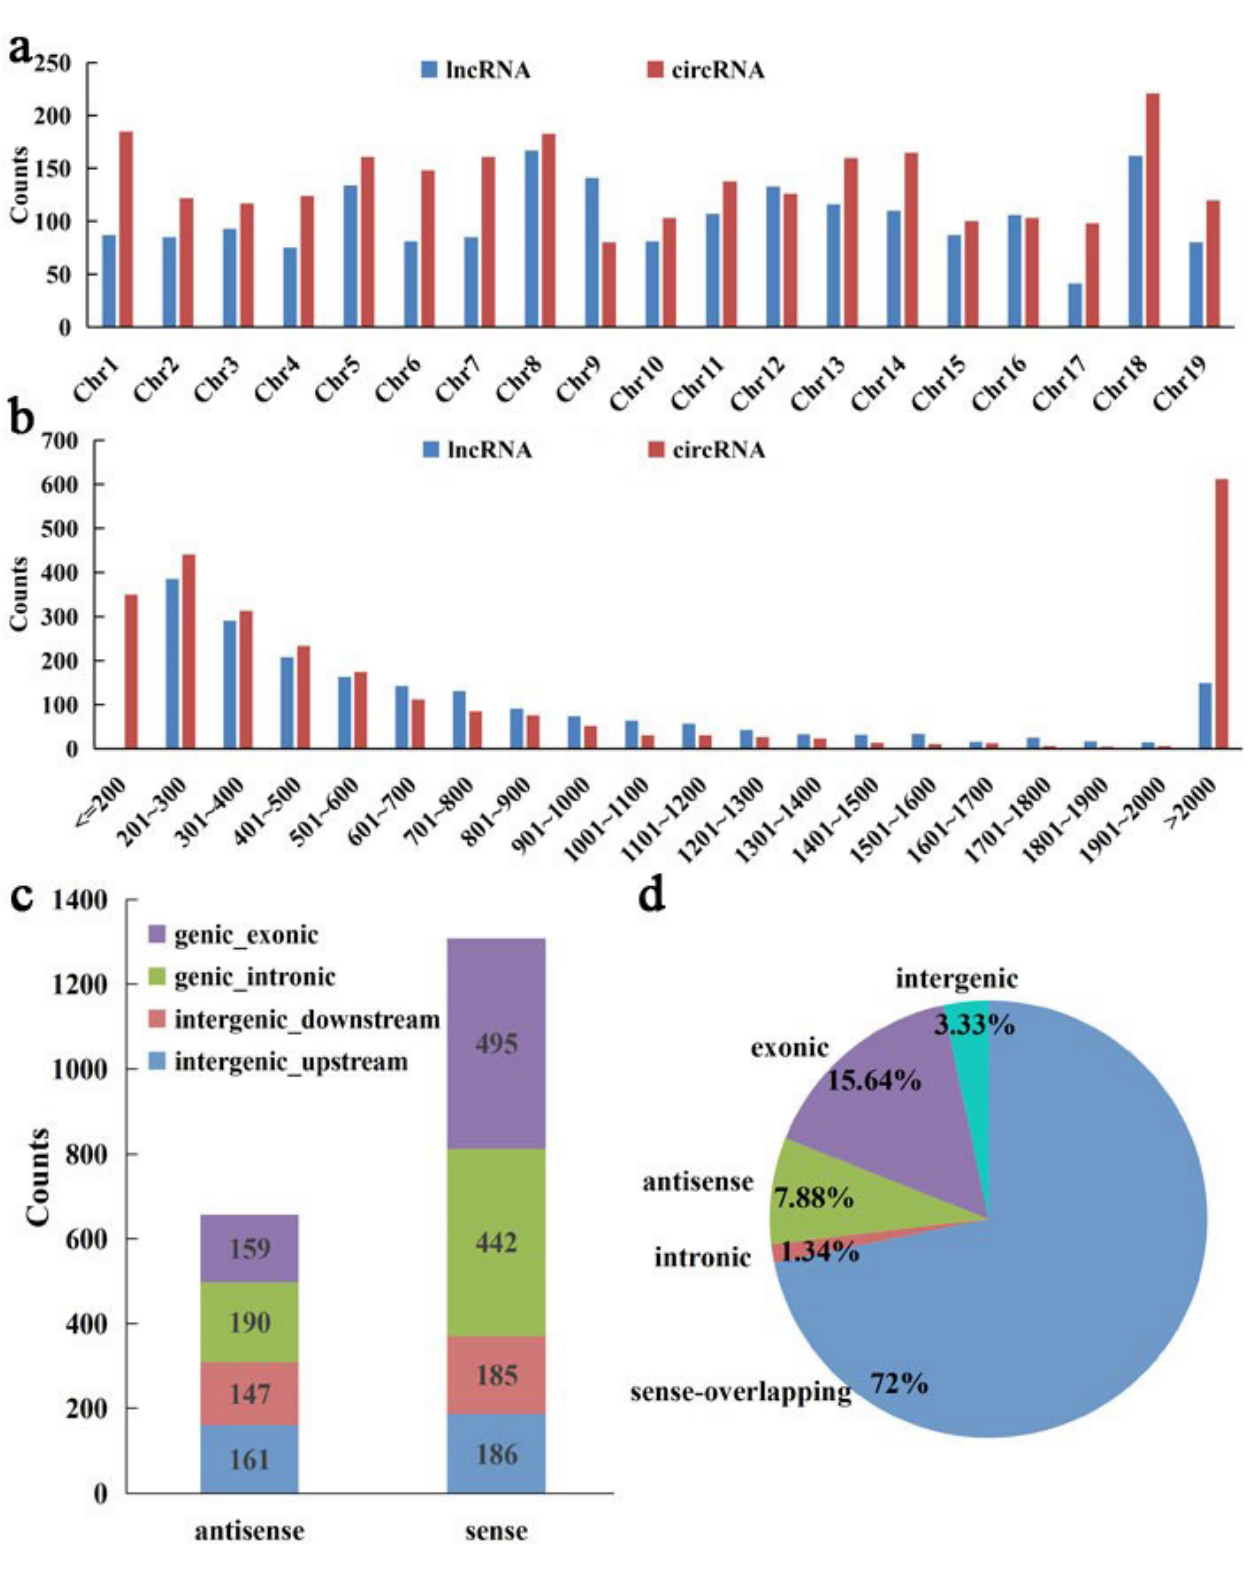
Figure 4. Comparison of the features of lncRNAs and circRNAs in the grapevine root. Chromosomes distribution ( a ), length distribution ( b ), and classification of lncRNAs ( c ) and circRNAs ( d ).